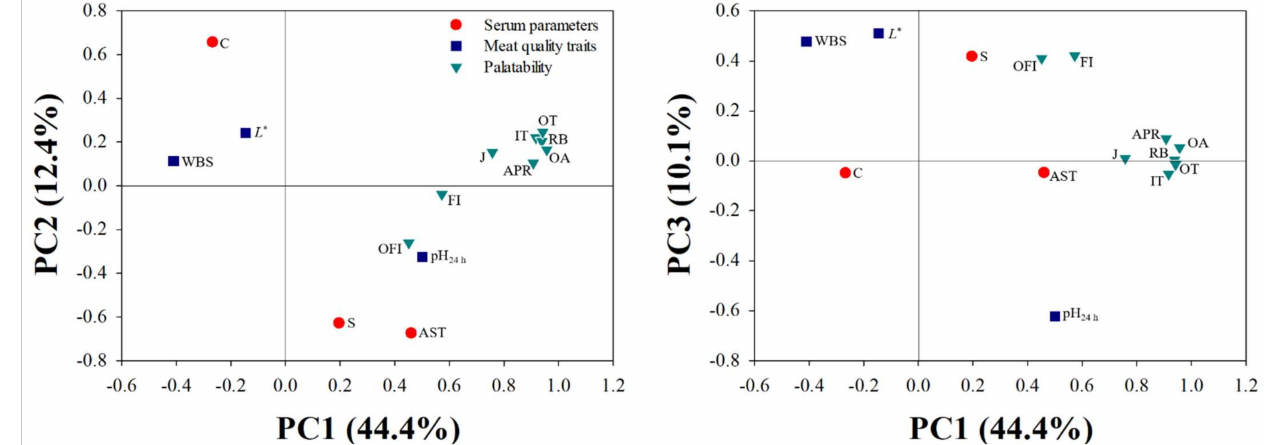
Figure 1. Principal component analysis (PCA) plots for PC1 vs. PC2 and PC1 vs. PC3. The percentage of variance explained by the three PCs was 66.9%. S, serotonin; AST, aspartate aminotransferase; C, calcium; L* , lightness; WBS, Warner–Bratzler shear force; IT, initial tenderness; RB, rate of breakdown; APR, amount of perceptible residue; OT, overall tenderness; J, juiciness; FI, flavor intensity; OFI, off-flavor intensity; OA, overall